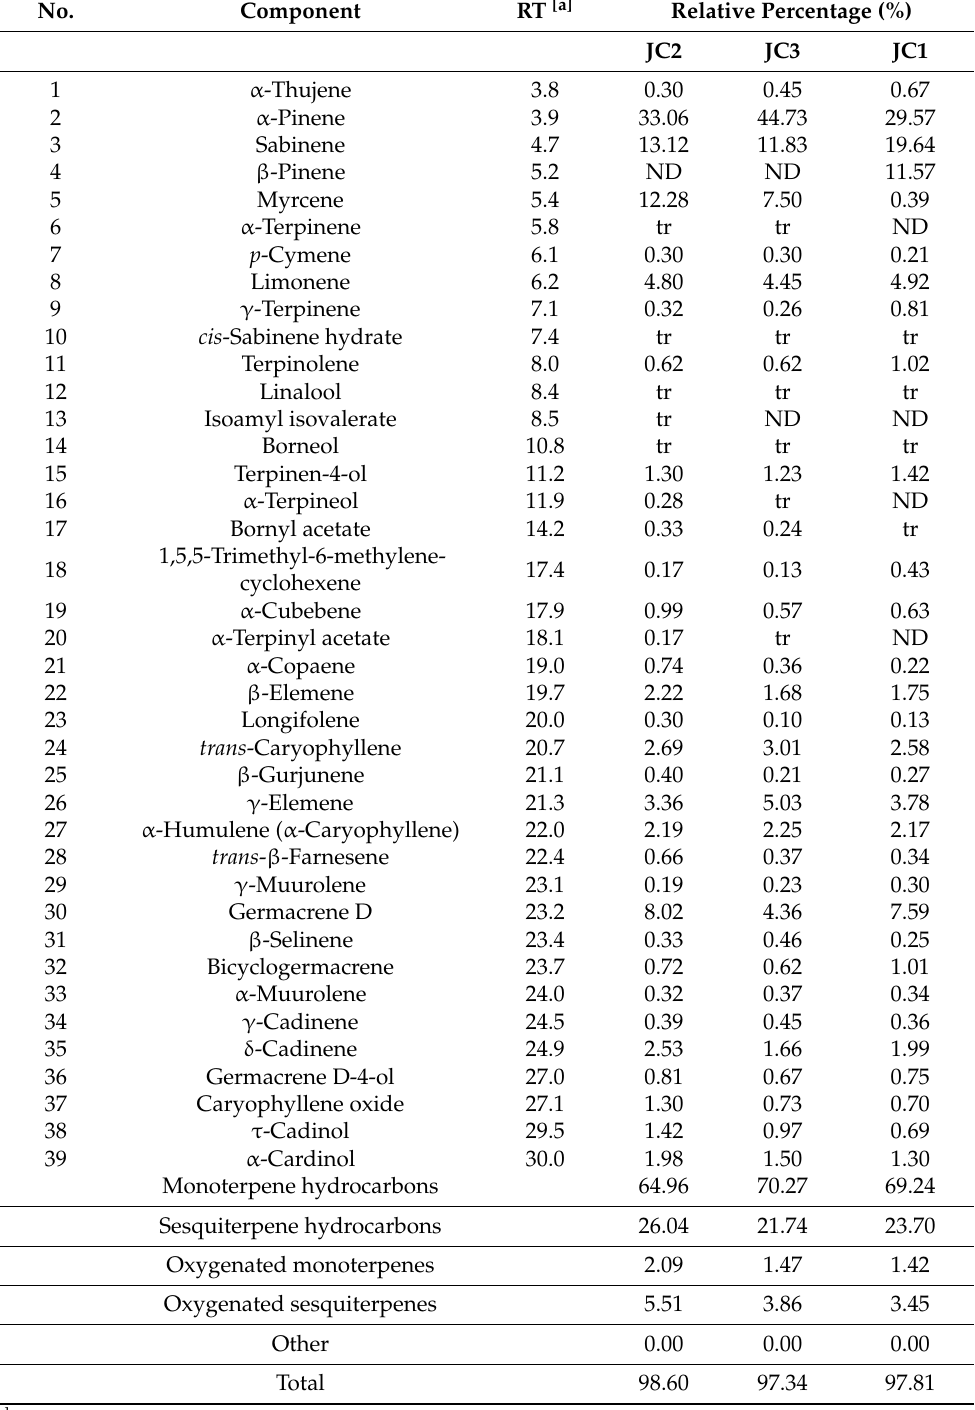
Table 5. GC-MS profile of EOs obtained from Cupressaceae